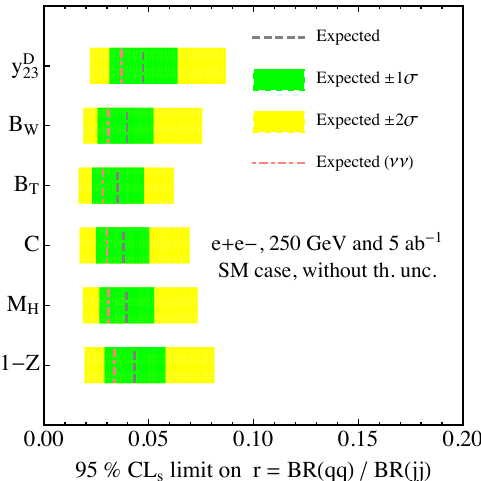
Figure 3 . Expected 95% CL s exclusion limit on r and the 1 σ and 2 σ fluctuations as a function of the total cross section of the Higgs boson decay to jj normalized to the SM value. The dot-dashed line is the expected exclusion limit when invisible decays of the Z boson are also included in the analysis.